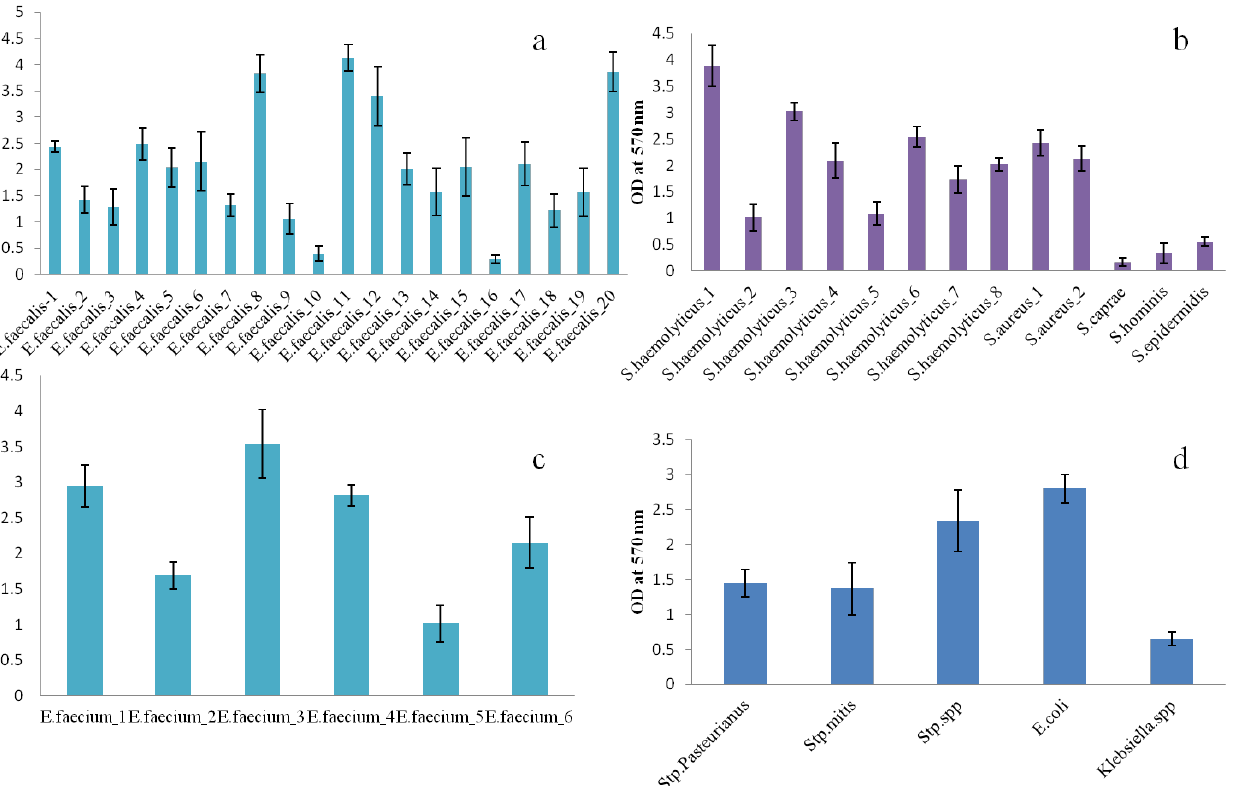
Figure 8. The biofilm formation by the different strains quantified by crystal violet staining. ( a ) Enterococcus faecalis strains; ( b ) staphylococcus strain; ( c ) Enterococcus faecium strains; ( d ) Stp: Streptococcus strains and enterobacterales strains.